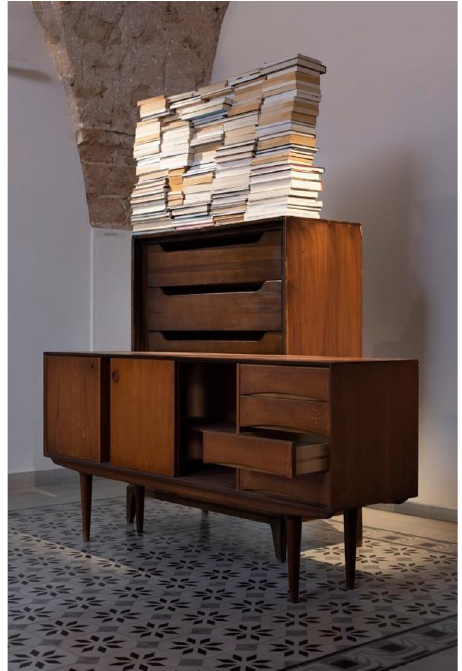
Figure 12: Leor Grady, Untitled ( Passage II ) ,